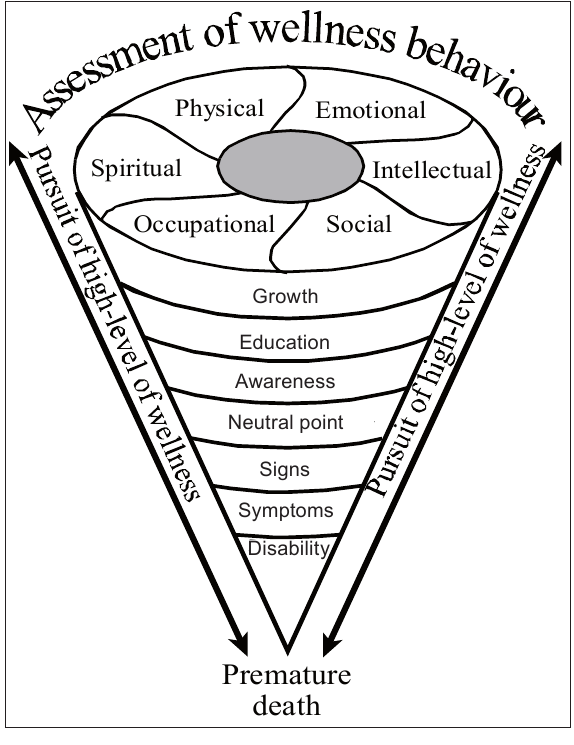
FIGURE 1 A preliminary wellness model for